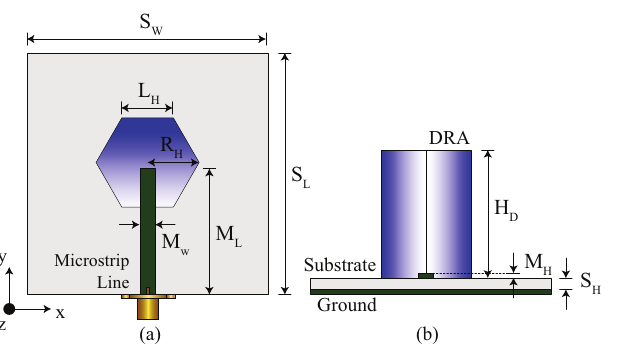
FIGURE 1: Conventional hexagonal DRA: (a) Top view (b) Perspective view. TABLE 1: Detailed dimensions of the single HDRA FIGURE 2: Effect on S 11 magnitude with different shaped